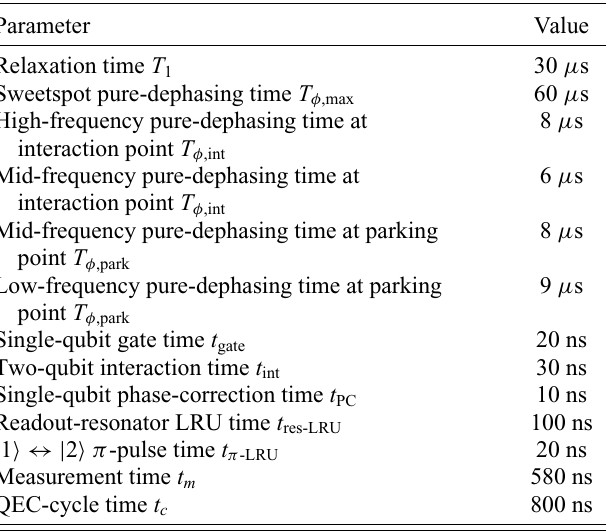
TABLE II. The parameters for the qubit coherence times and for the gate, LRU, measurement, and QEC-cycle durations used in the density-matrix simulations. The interaction point cor- responds to the frequency to which a transmon is fluxed to implement a CZ gate, whereas the parking point corresponds to the frequency at which the ancilla qubits are parked during measurement